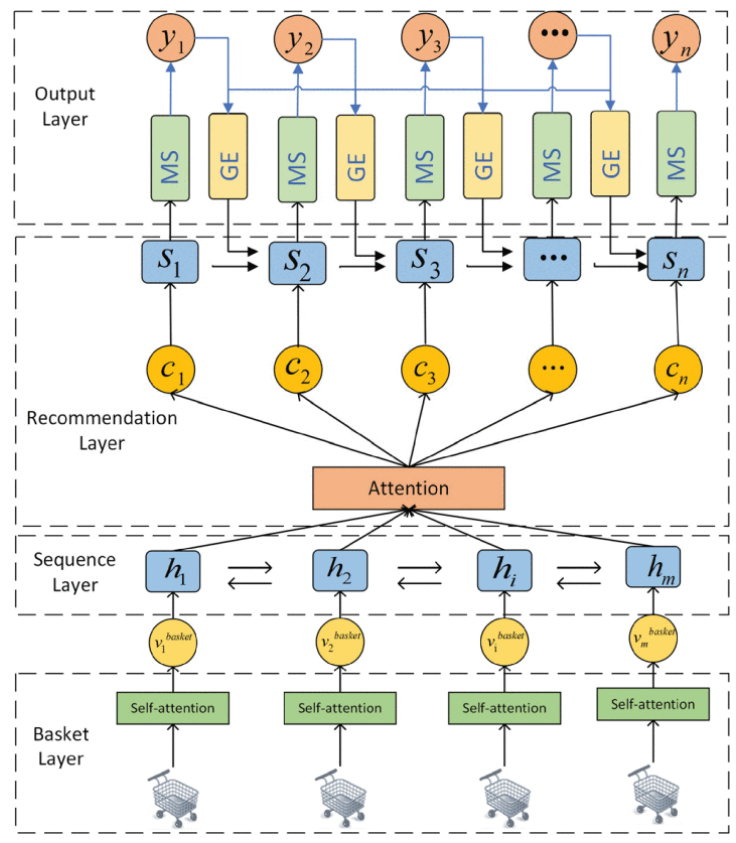
Figure 3. Attention-based LSTM model.